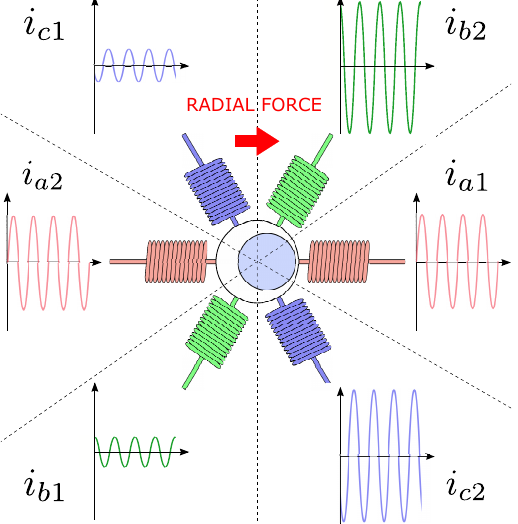
Figure 4. Stator of the bearingless induction motor with split-winding subjected to right-side ra- dial